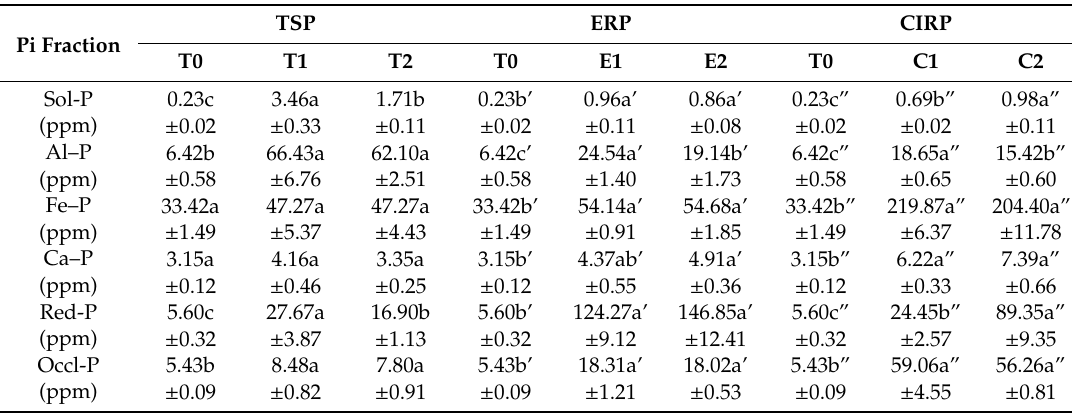
Table 7. Inorganic phosphorus speciation of soil at forty-nine days after seeding. TSP ERP Pi Fraction